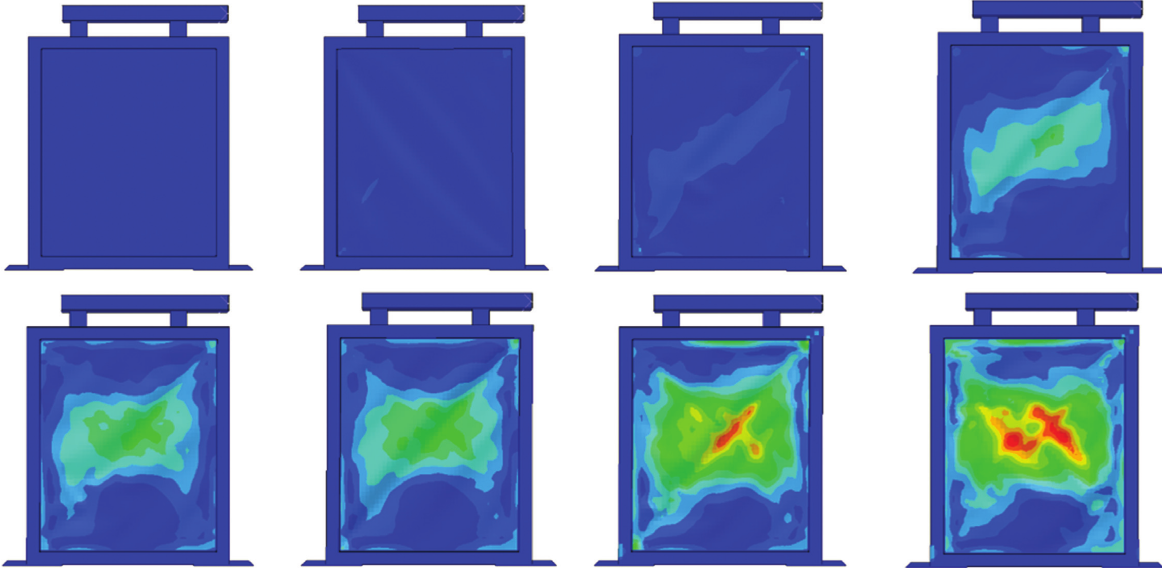
Figure 12: The plastic strain contour in 8 steps for shear wall under cyclic load of the laboratory